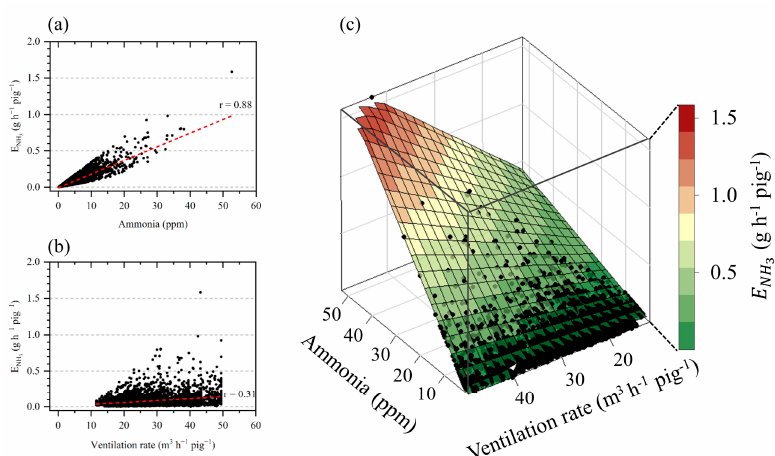
Figure 6. Scatter plots of hourly ammonia emission according to ( a ) ammonia concentration and ( b ) ventilation rate. ( c ) Three-dimensional scatter plot of hourly ammonia concentration, ventilation rate, and ammonia emission. The surface plane represents the regression model calculated using Equation (5), and the black circles represent measured data.